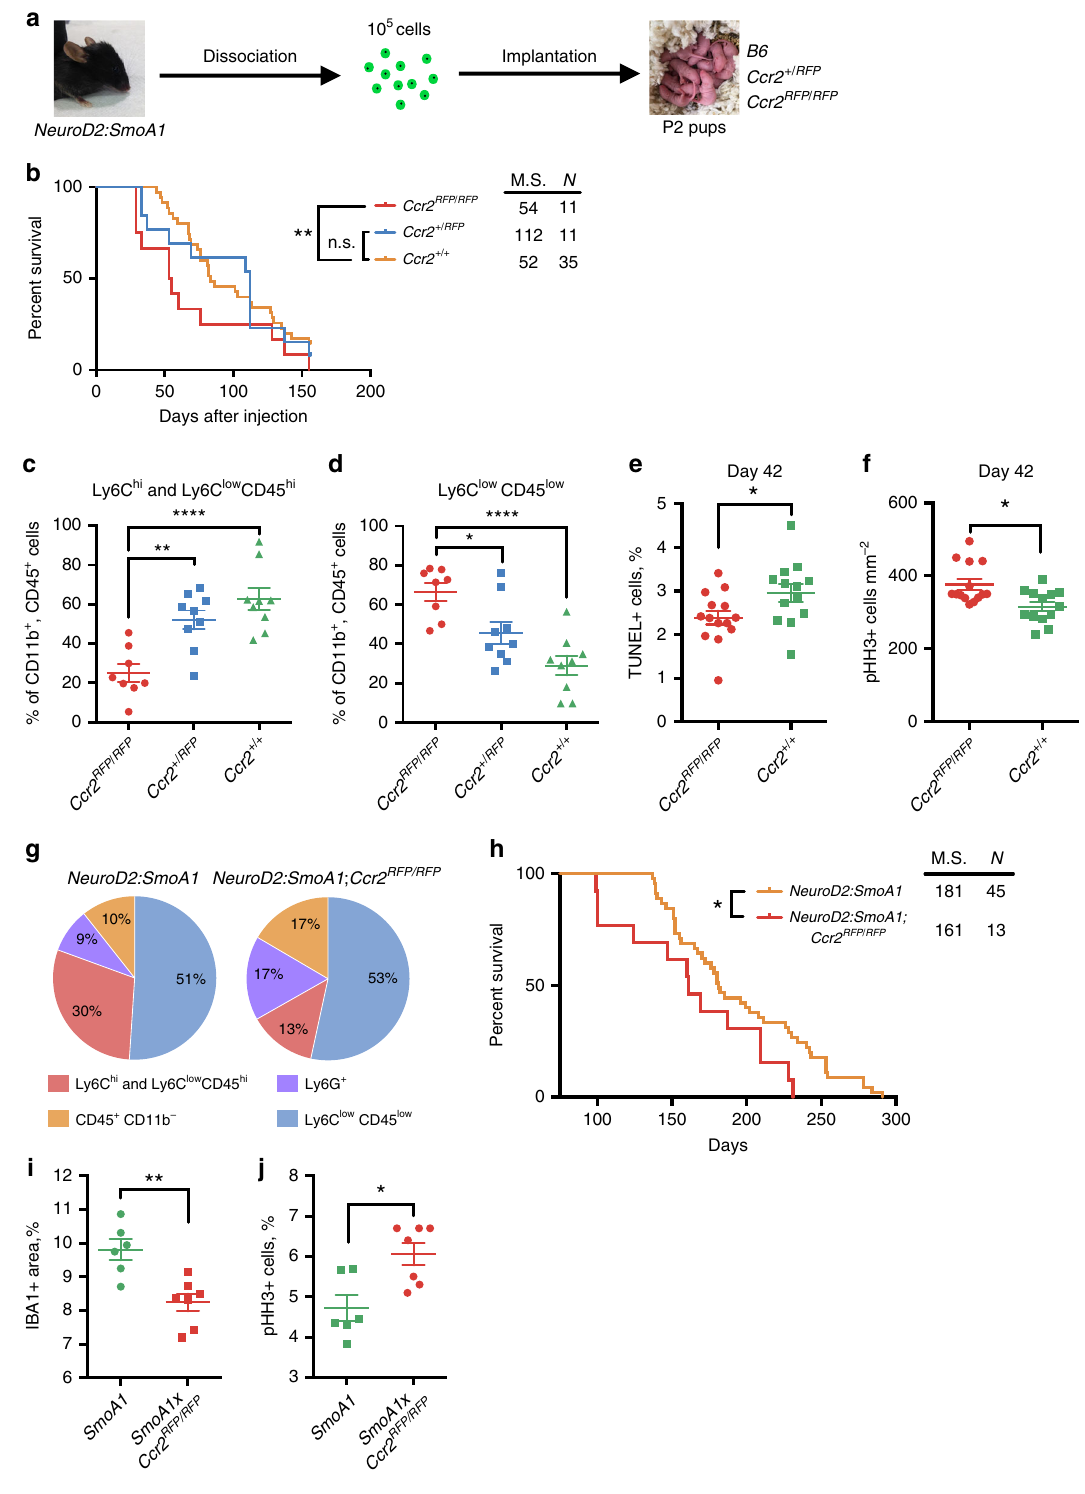
1.1%, mean ± S.E.M., N = 4) and proliferation (phospho-H3 + , 3.1 ± 0.2 vs. 3.5 ± 0.2%) levels in Ccr2 RFP/RFP vs. Ccr2 + / + mice